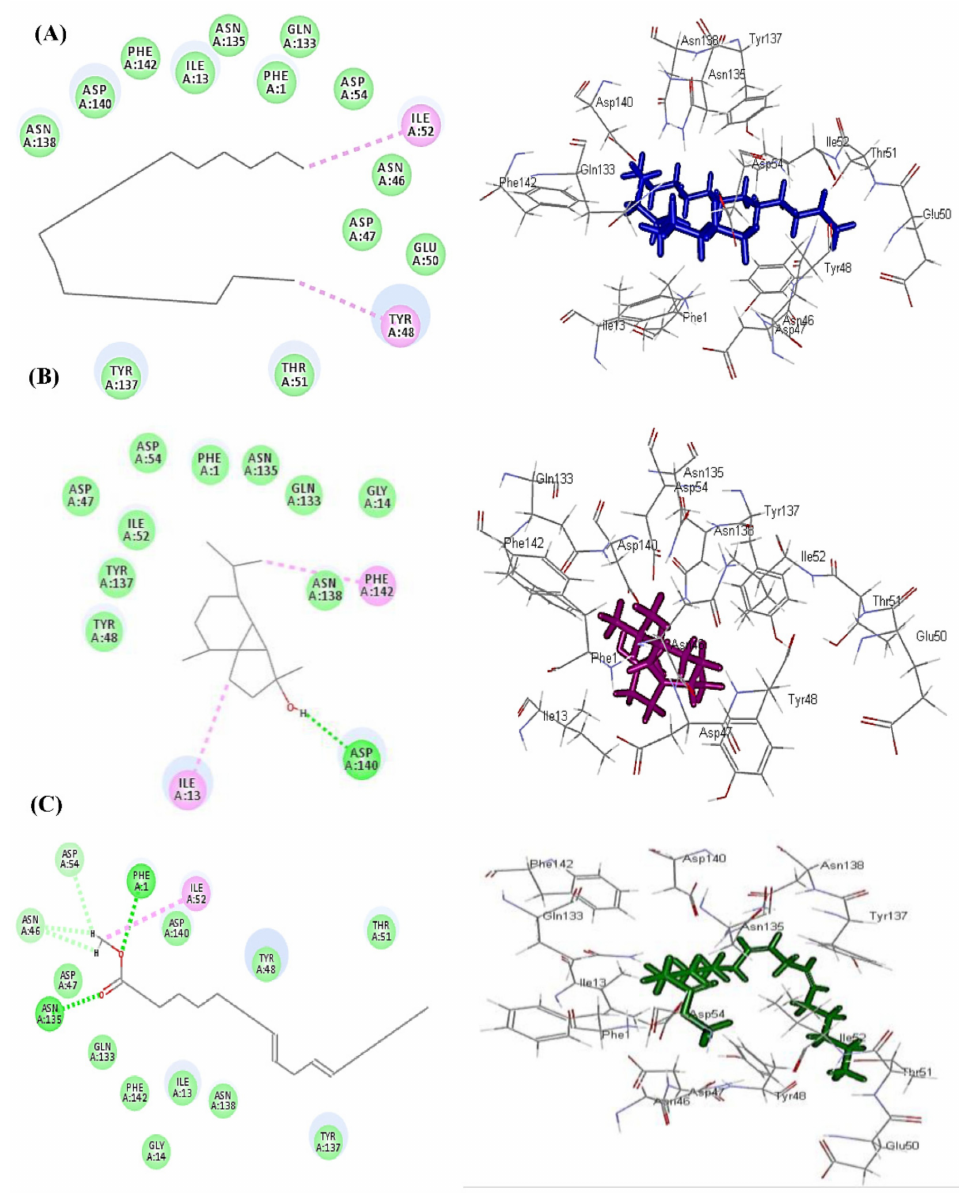
Figure 4. 2D and 3D binding modes of heneicosane ( A ), cubebol ( B ) and methyl linoleate ( C ) within the active center of E. coli adhesion protein FimH using in silico studies employing the C-docker